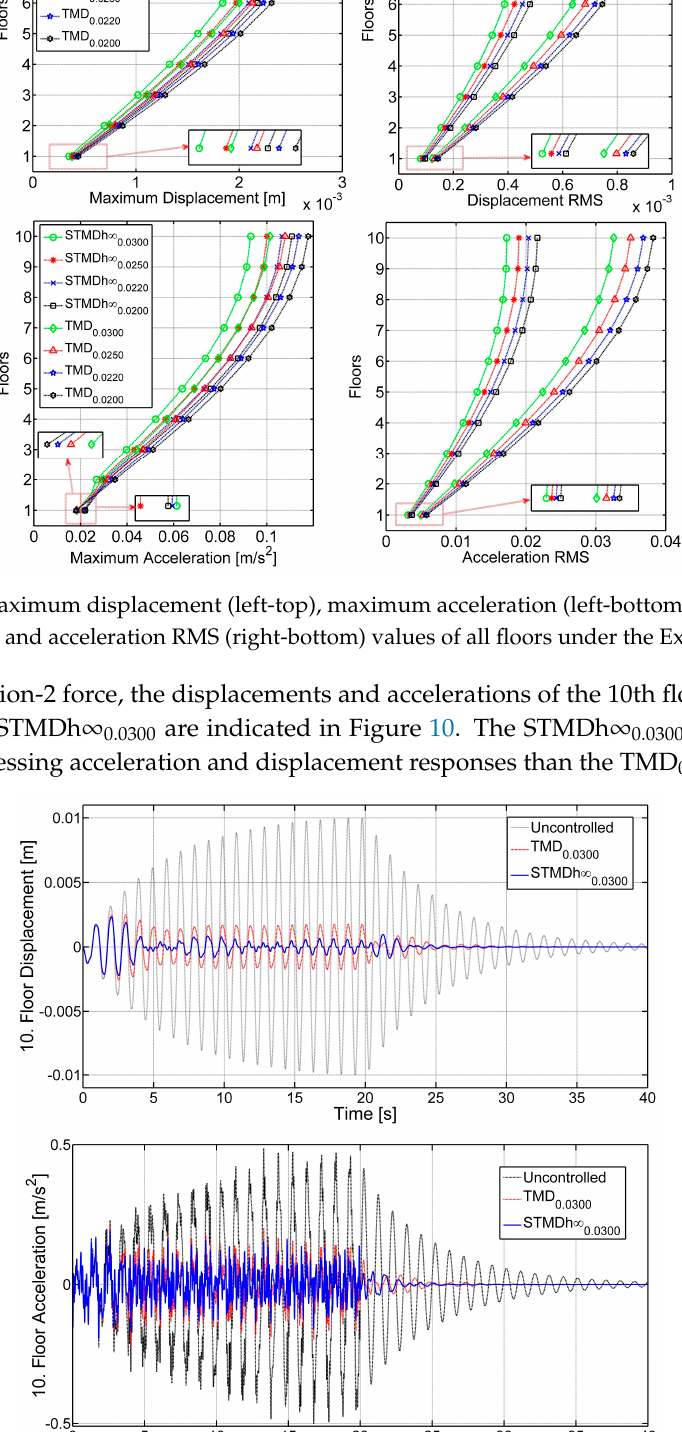
Figure 10. The TMD (cid:2868).(cid:2868)(cid:2871)(cid:2868)(cid:2868) and the STMDh∞ (cid:2868).(cid:2868)(cid:2871)(cid:2868)(cid:2868) , the displacements (top) and accelerations (bottom) under the Excitation-2 force.